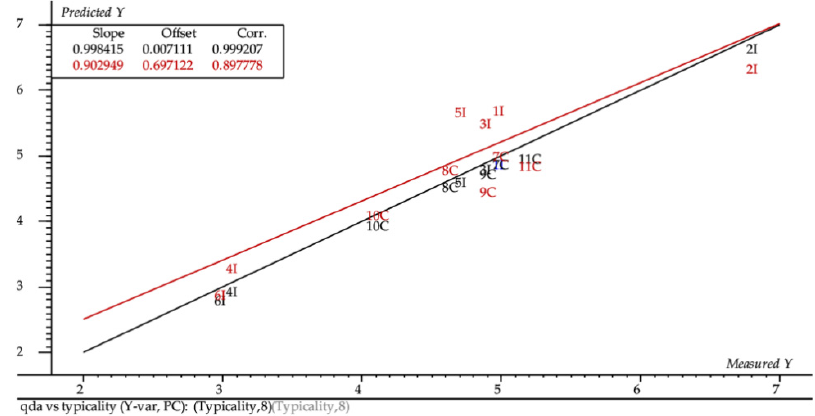
Figure 5. Partial least square regression (PLS-1) model for prediction of the typicality scores of wines by identity sensory attributes. Marked attributes with the circle around the dot were considered the important variables according to the uncertainty test (Earthy, Cherry, and Red berries).